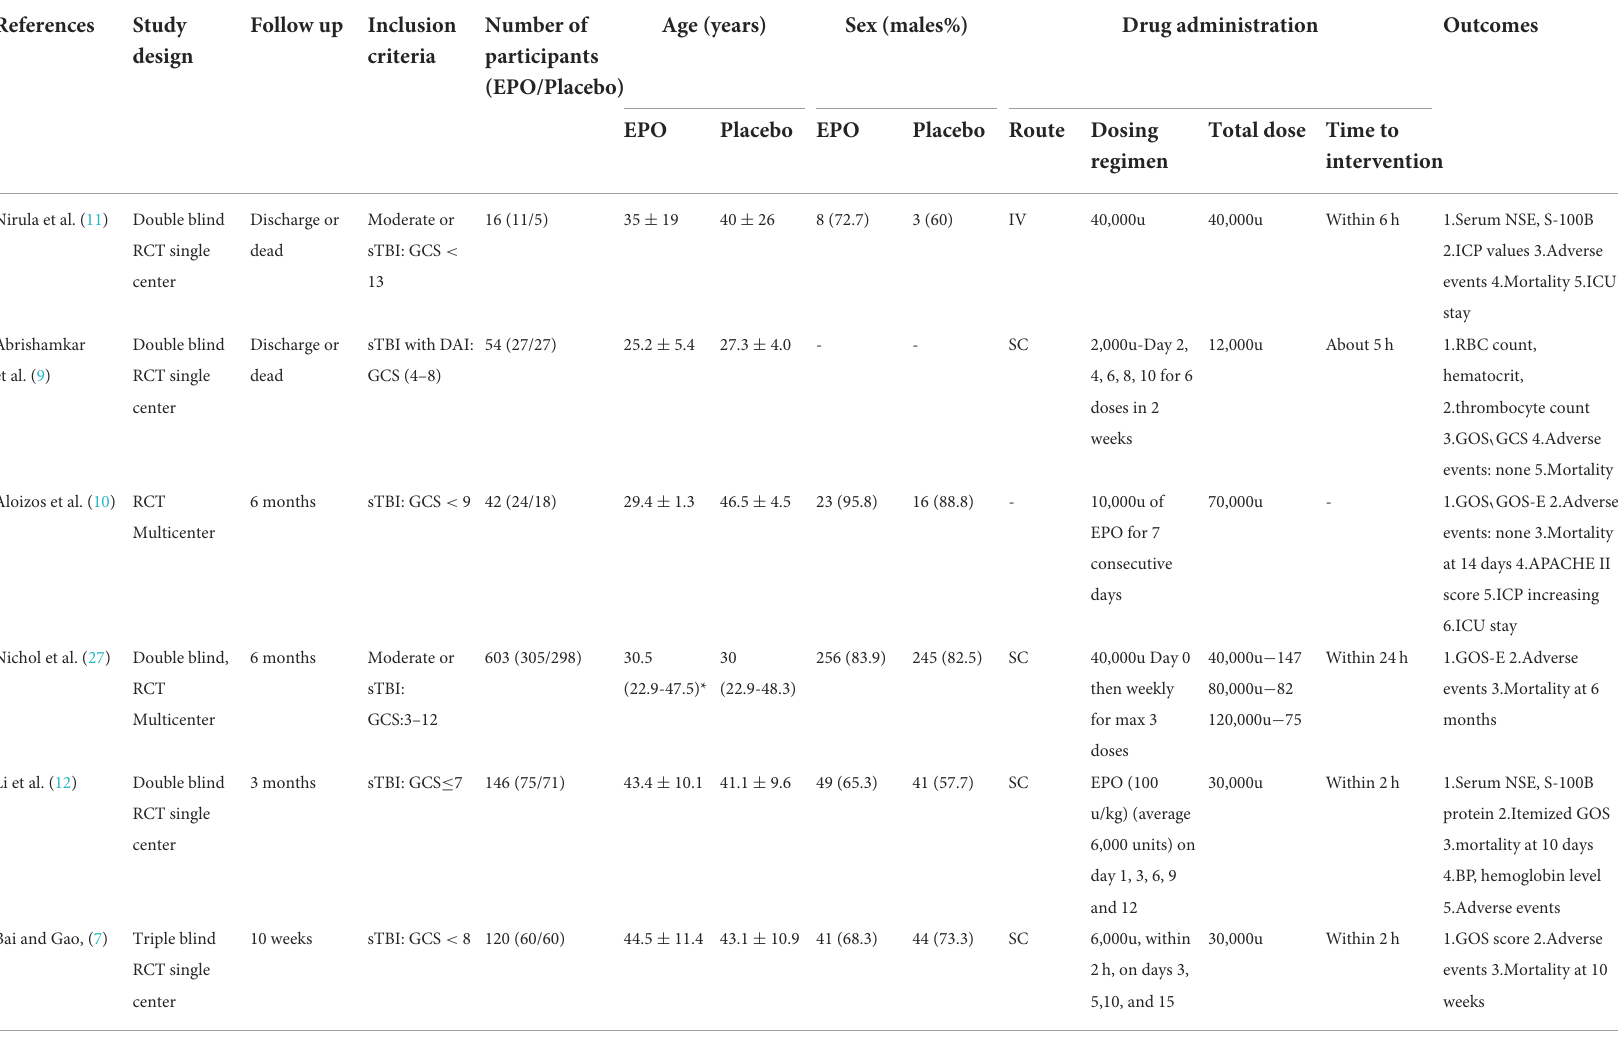
TABLE 1 Baseline characteristics of included